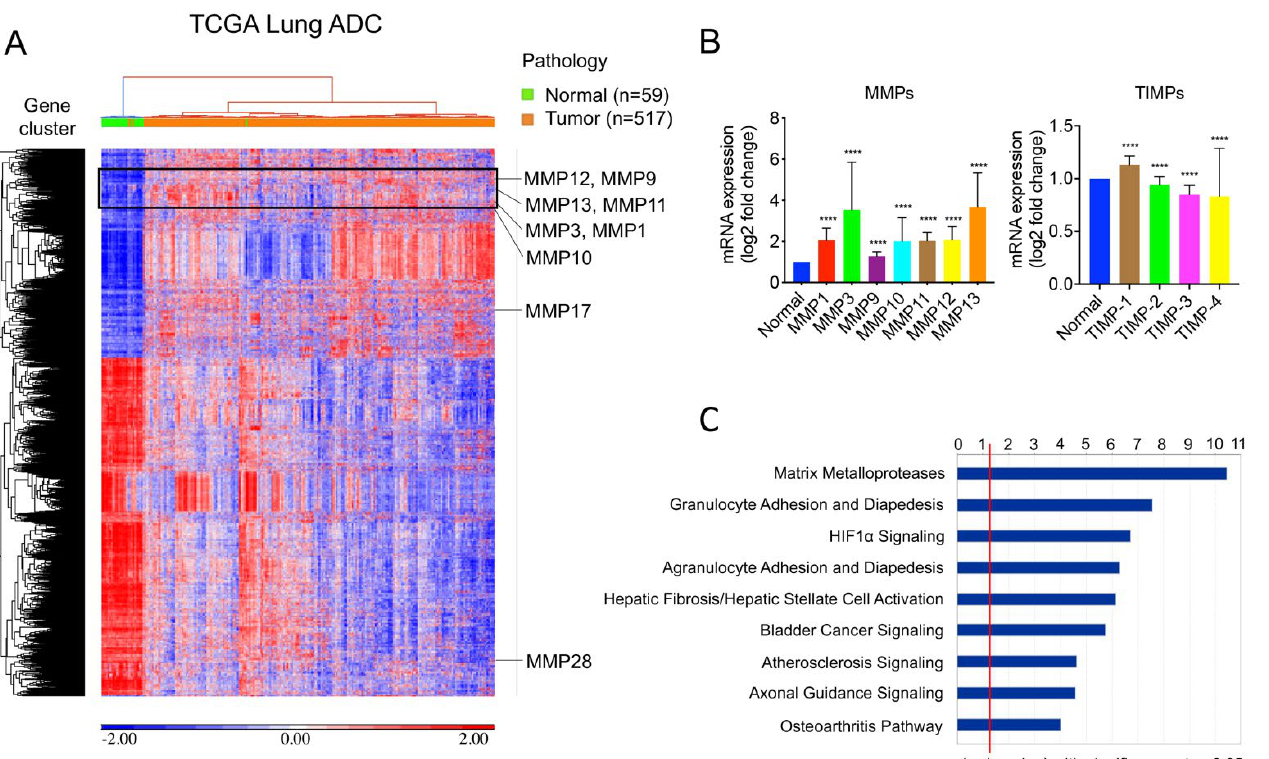
Figure 2. MMPs increase expression in lung tumors and are associated with survival outcomes in the TCGA cohort; 517 lung adenocarcinoma patient samples and 59 normal adjacent lung samples from the TCGA lung adenocarcinoma cohort were analyzed: ( A ) An unsupervised hierarchical clustering heatmap of differentially expressed genes between tumor and normal lung tissue was